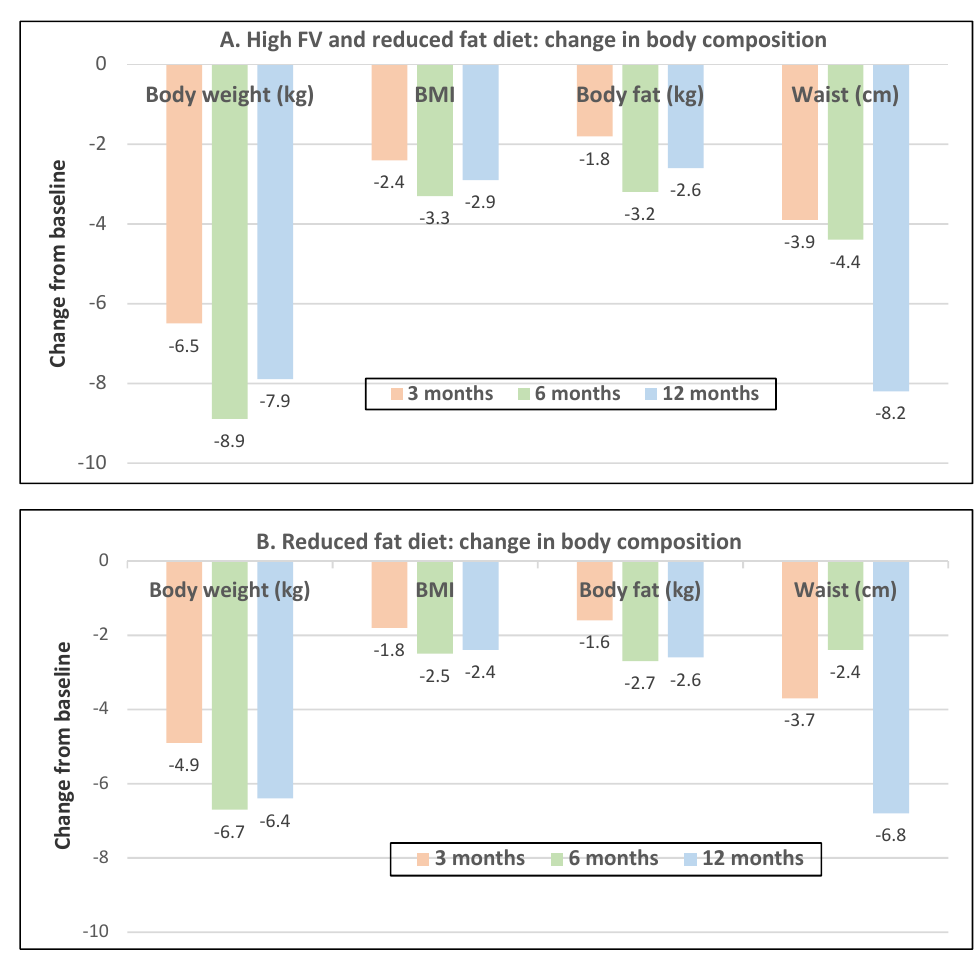
Figure 19. In 71 obese women (mean age 46 years) two ad libitum diets were assessed over one year: (A) increased fruits and vegetables (FV), and reduced-fat diet reduced weight, BMI and body fat ( p < 0.0001) and waist circumference ( p = 0.0002) compared to the (B) reduced-fat diet only control diet [58].